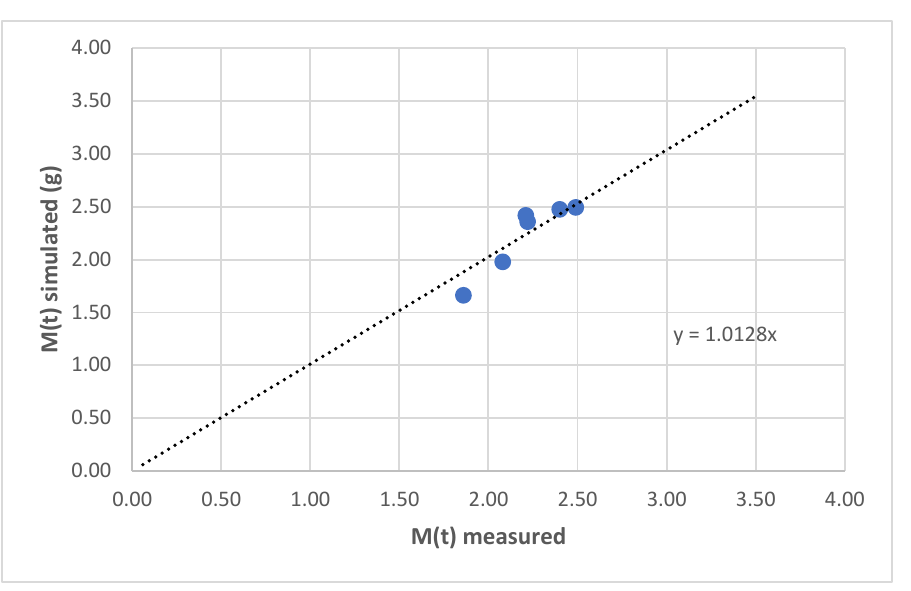
Figure 7. Trends of the real and simulated decomposition for M 1 ( a ) and M 2 ( b ) compared to the respective M pools derived by simulations with the appropriate CDI.